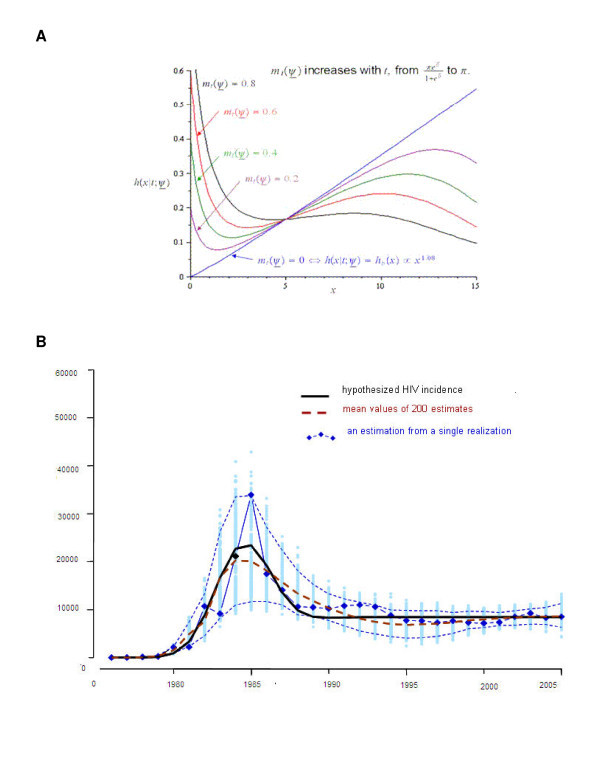
Sensitivity analysis. (A). Shapes of hazard function of the mixture model, h(x|t; φ) for various values of mt(φ). (B). Results from simulation study: the mean values of the HIV incidence estimates from 200 realizations are shown with the broken red line; the hypothetical HIV incidence is shown with the black solid line.